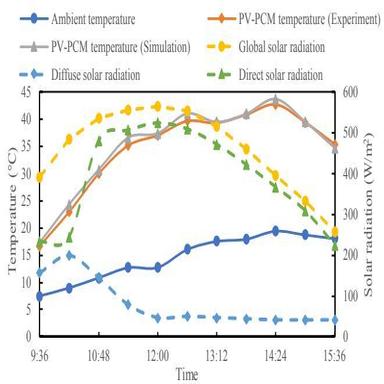
The validation results of the PV/T-PCM system: a) the solar radiation intensity and the ambient temperature ; b) the PV cells temperature.